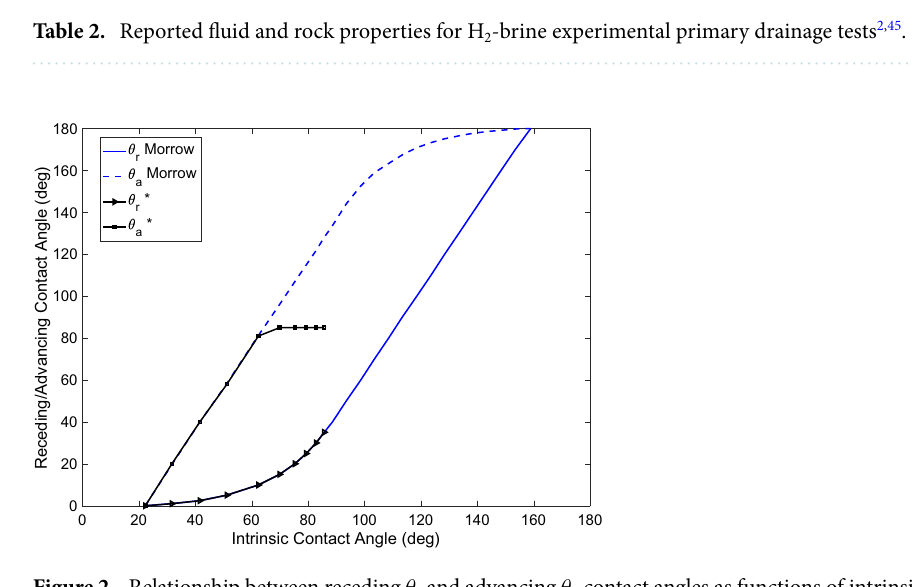
Figure 2. Relationship between receding θ r and advancing θ a contact angles as functions of intrinsic contact angle θ i , based on the literature 37,46 . *Indicates the modified relationship, which is defined in this work, to maintain water-wet rock conditions at all